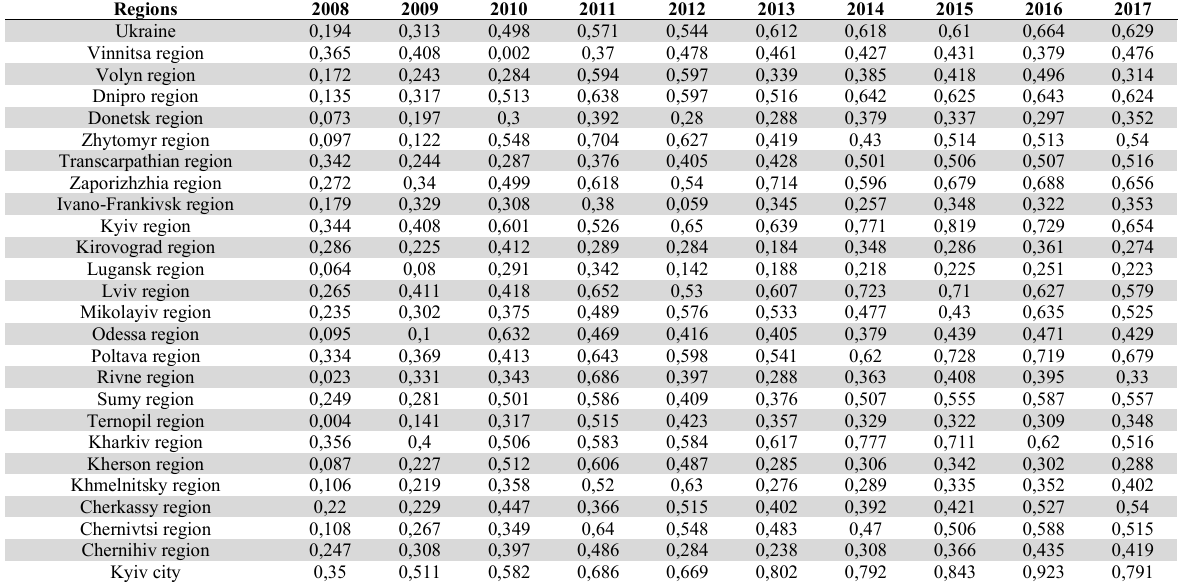
Table 2 Integral indicator of the development level of regions and Ukraine Regions